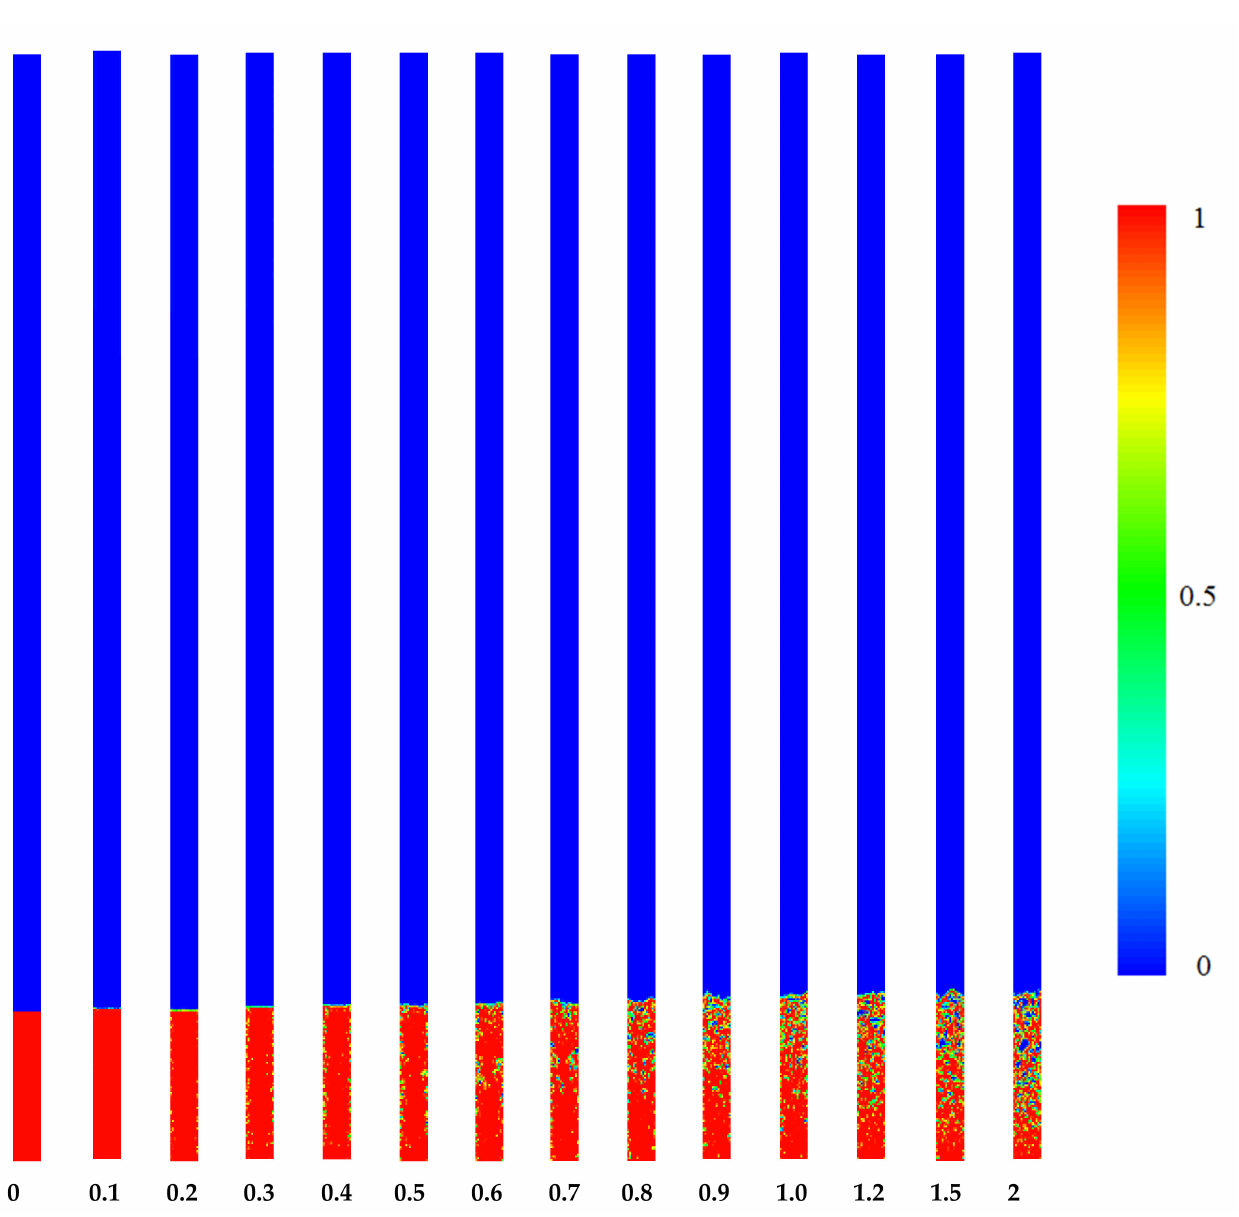
Figure 10. Contours of volume fraction in entire parts of TPCT at different times for FR =